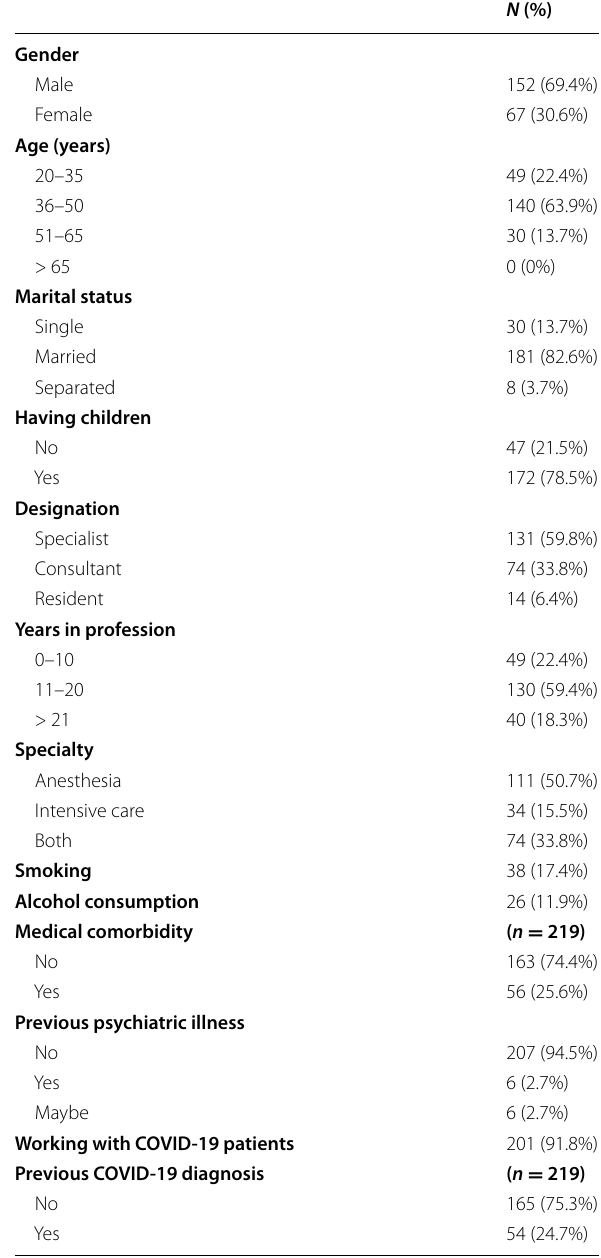
Table 1 Sample characteristics ( n